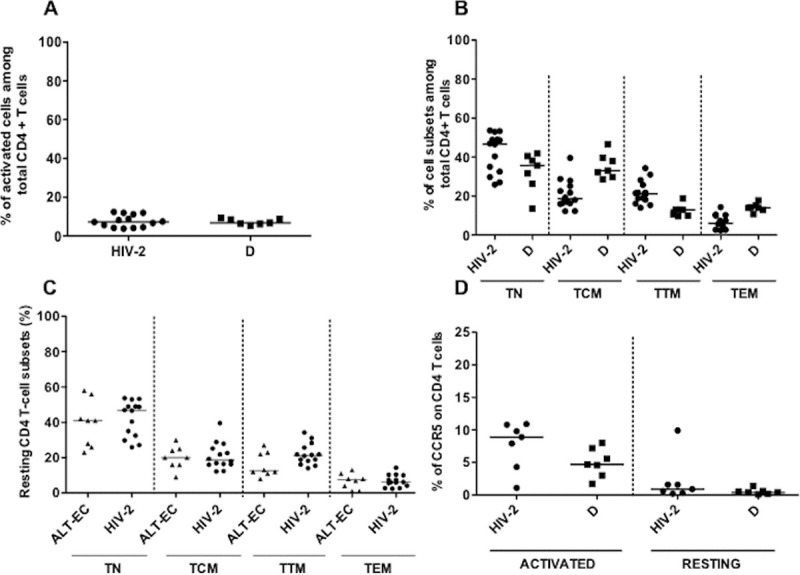
A) Percentage of activated CD4 T lymphocytes (left panel) of 14 HIV-2 infected subjects (dots) compared to 7 donors (D) (squares). Each symbol represents a subject and the medians are shown. B) The repartition of resting CD4 T-cell subsets was assessed in 14 HIV-2 infected subjects (dots) and in 7 donors (D) (squares). The analyzed resting CD4+ subsets are: naive (TN; CD45RA+CCR7+CD27+) central-memory (TCM; CD45RA-CCR7+CD27+) transitional memory (TTM; CD45RA-CCR7-CD27+) and effector-memory cells (TEM; CD45RA-CCR7-CD27-). Each symbol represents a subject and the medians are shown. C) Resting CD4 T-cell subsets of 7 HIV-2 infected subjects (dots) compared to 8 HIV-1 infected Long-Term-Non-Progressors (ALT) (triangles). The analyzed resting CD4+ subsets are TN, TCM, TTM and TEM. Each symbol represents a subject and the medians are shown. D) Expression of CCR5 on CD4 T-cells activated and resting CD4 T-cells from 7 HIV-2 infected subjects (dots) compared to 7 donors (D) (squares). Each symbol represents a subject and the medians are shown.